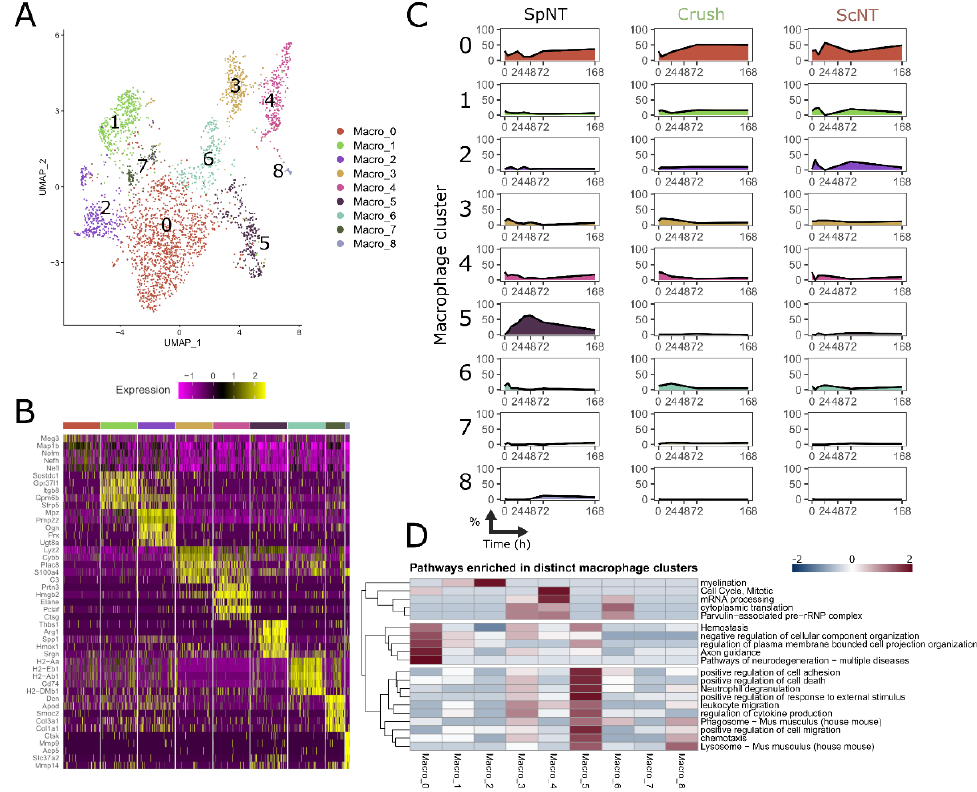
Figure 4. Macrophages can be divided into transcriptionally distinct clusters which correspond to varying phenotypes. ( A ) UMAP dimensional reduction plot showing the clustering of macrophages into nine distinct clusters. ( B ) Top 5 marker genes defining the macrophage clusters. ( C ) Relative proportion of each macrophage cluster shown for the different nerve injury models over time. The y-axis corresponds to the percentage of individual cluster from all macrophages and the x-axis scale is transformed to log2 for the visualization. ( D ) Summary of the most enriched pathways among the distinct macrophage clusters. The color gradient represents the LogP values calculated by the Metascape pathway analysis tool. Marker genes having adjusted p -value < 0.05 were used, and if